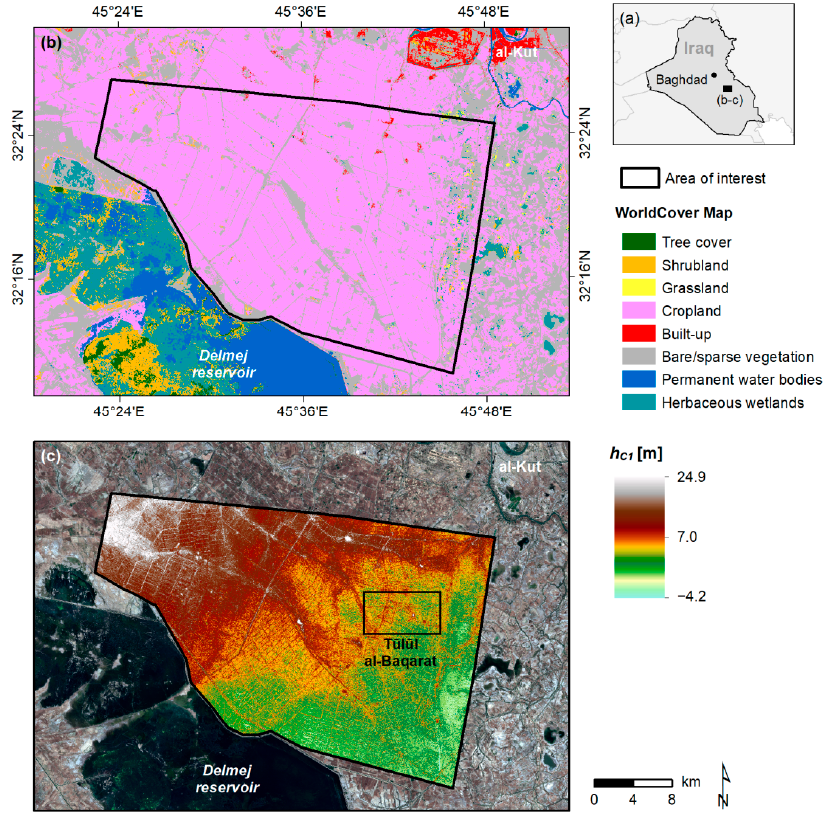
Figure 1. ( a ) Location of Al-Ahrar, Al-Nu’maniya, Wasit (Iraq) and indication of the zoomed area in subfigures ( b , c ). ( b ) Land cover according to the WorldCover 10 m dataset (©ESA